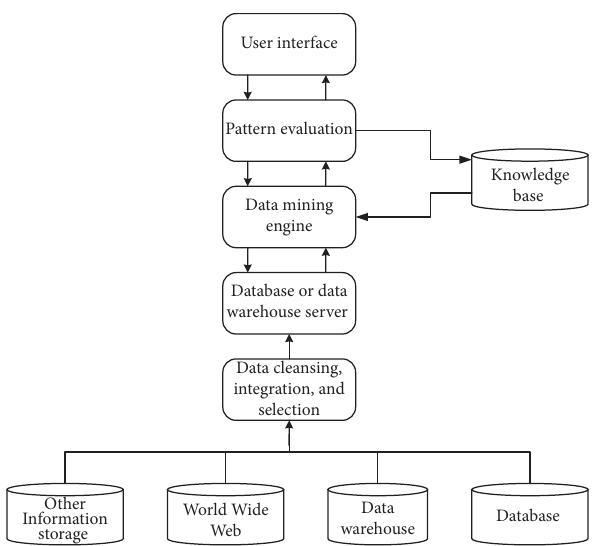
Figure 1: Typical data mining system structure.